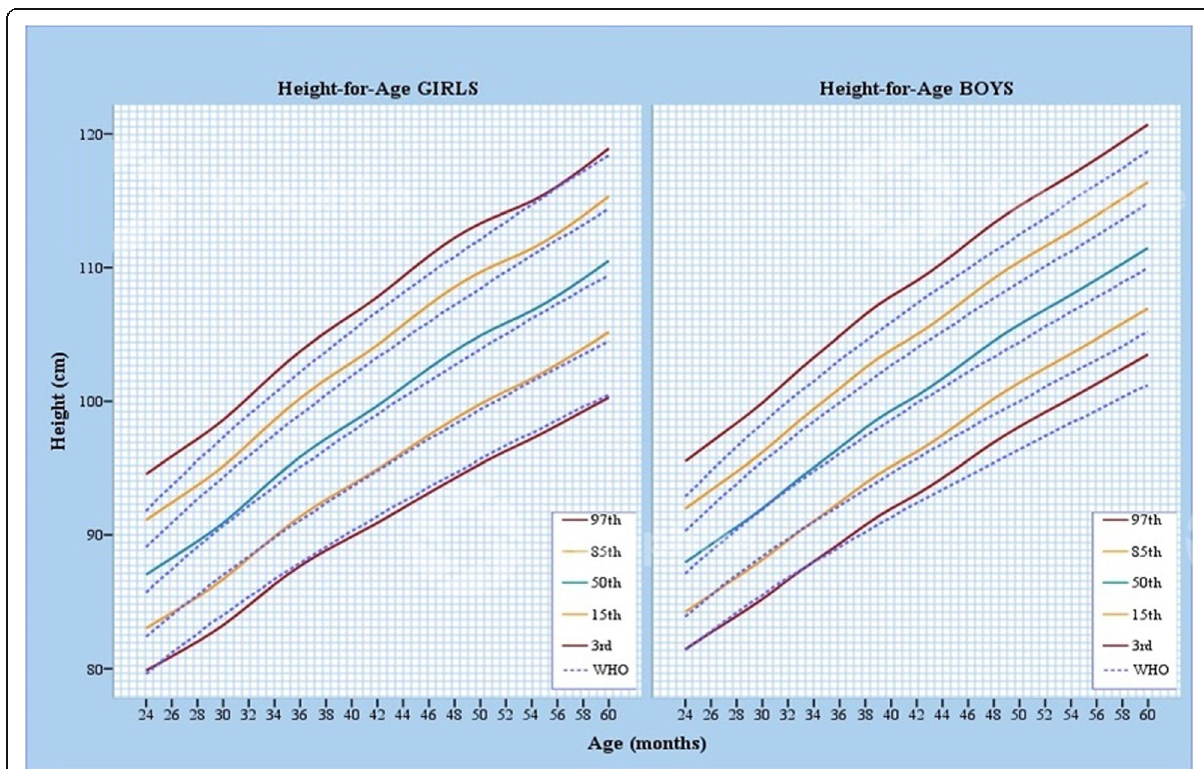
Fig. 1 Height percentiles (P3, P15, P50, P85, and P97) by age for girls and boys ages 2 – 5 years who were born in Isfahan compared to the WHO growth